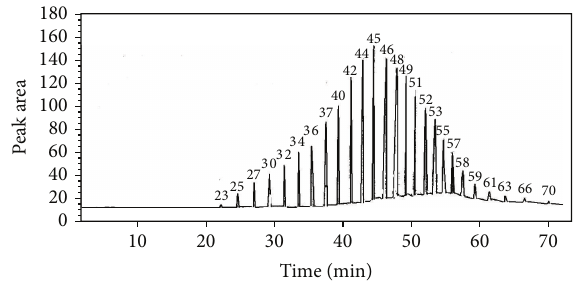
Figure 4: Chromatogram of paraffins extracted from Norpetco crude oil.